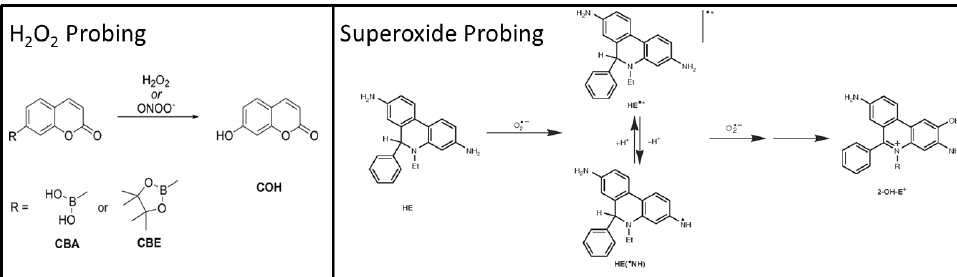
Figure 1. Formation of specific adducts from reaction of probes with targeted reactive oxygen species. CBA: Coumarin boronic acid (detected as the formiate adduct C 10 H 8 BO 6 − ; m / z 235.0419 (th)), CBE: pinacolate ester of Coumarin boronic acid, COH: 7-hydroxycoumarin (detected as the